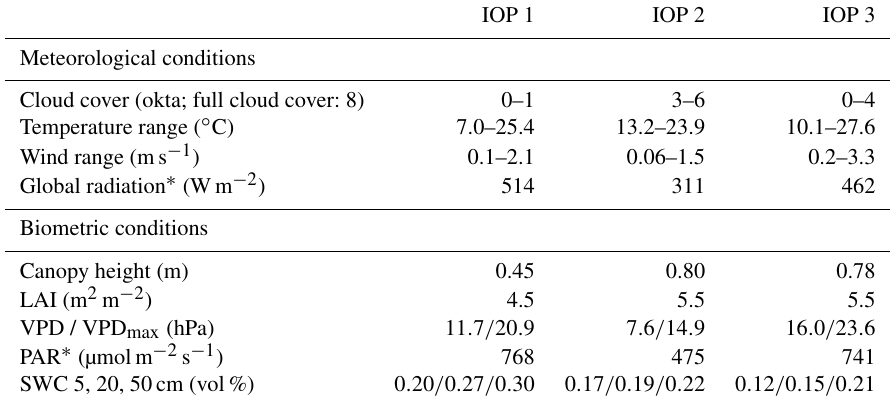
Figure 2. Campaign-specific measurement setup and temporal developments from May to June 2018, including three intensive operation periods (IOP). Table 1. Meteorological and biometric conditions during the intensive operation periods on 7 May (IOP 1), 15 June (IOP 2), and 28 June 2018 (IOP 3). Global radiation, water vapour–pressure deficit (VPD), photosynthetically active radiation (PAR), and soil water content (SWC) are daily averages. The meteorological variables were measured at the height 2 . 4 ± 0 . 1m (see Sect. 2.3.7 for details). IOP 1 IOP